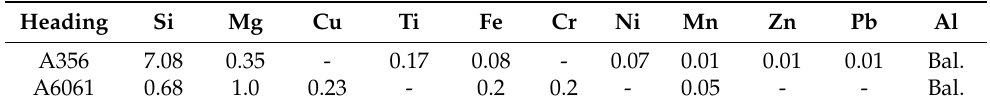
Table 1. Chemical composition of A356 alloy and A6061